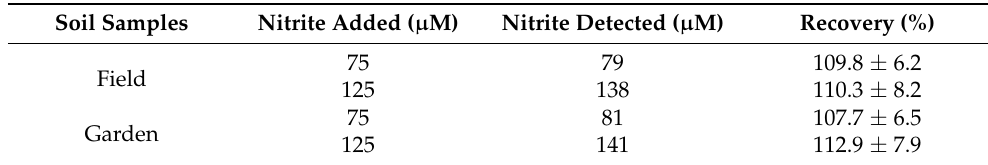
Table 4. Detection of nitrite in spiked soil samples. Soil Samples Nitrite Added ( µ M) Nitrite Detected ( µ